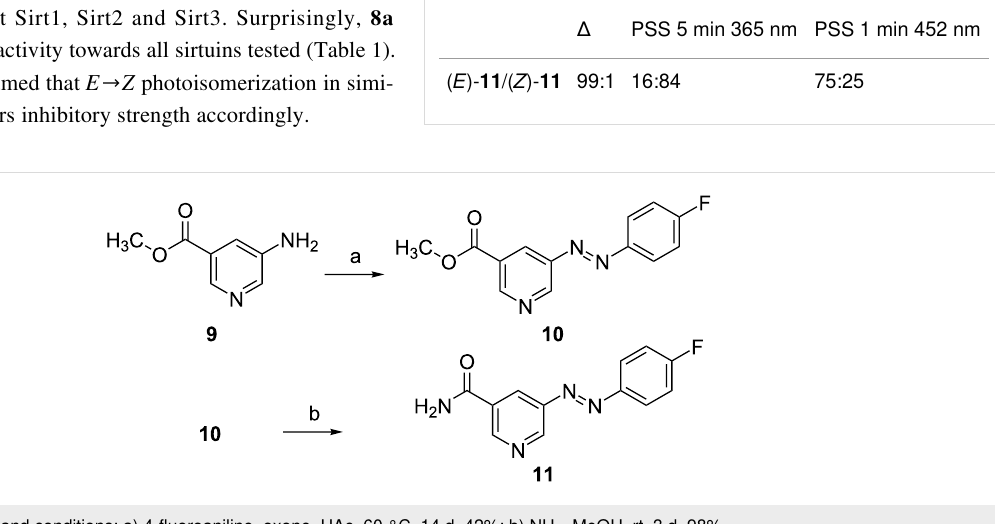
Table 2: Percentage of E / Z -isomers of 11 at the thermal equilibrium ( ∆ ), and photostationary states (PSS) after 365 nm and 452 nm irradi-